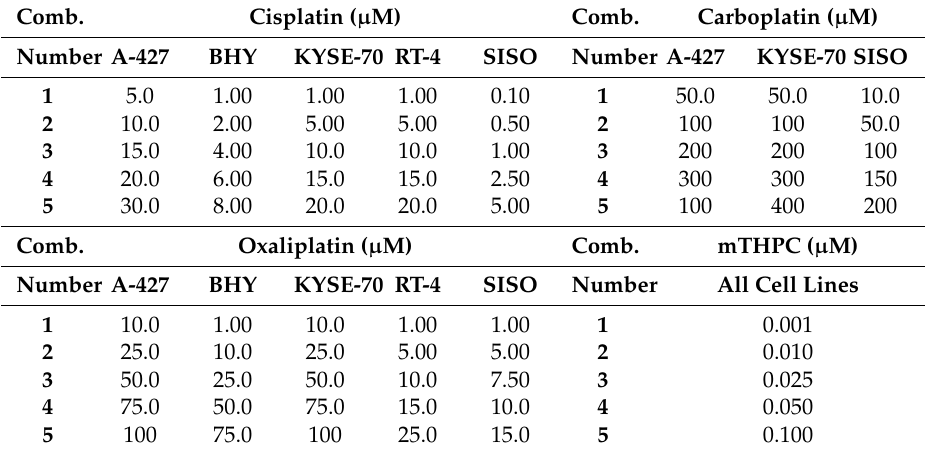
Table 2. Cell-specific concentrations of mTHPC and Pt(II) complexes as used in the combination assay. For each cell line, each of the concentration for mTHPC and CDDP, CBDCA, or 1-OHP was tested alone or the concentrations for a Pt(II) complex were combined with a mTHPC concentration with the identical assigned combination number. Comb. Cisplatin ( µ M) Comb. Carboplatin ( µ M)